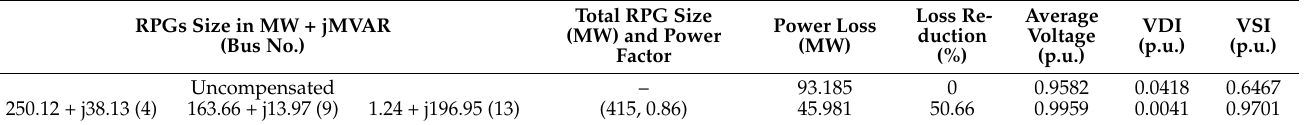
Table 5. RPGs locations at LPF.